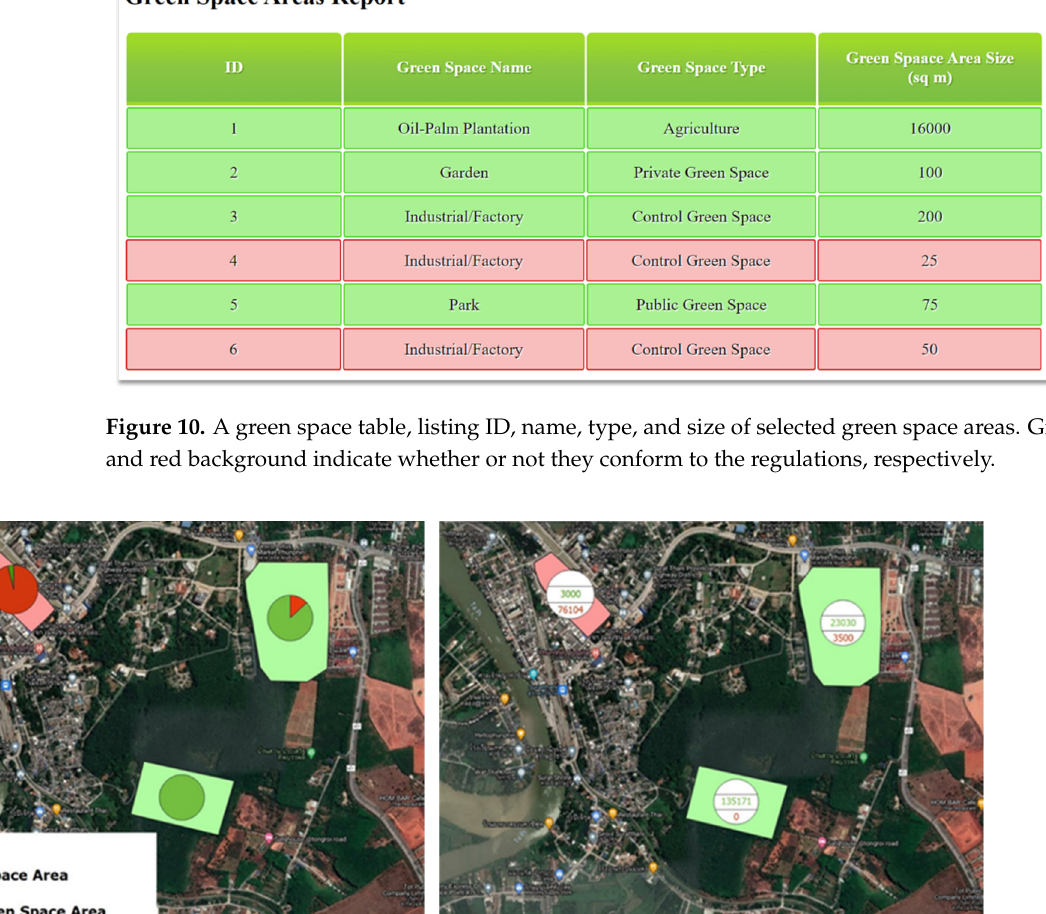
Figure 9. Verifications of green space (left) and non-green space area (right), showing submitted digitization, overlaid on satellite images ( a , d ), greenness results by satellite image analysis ( b , e ), and corresponding LULC data ( c , f ).